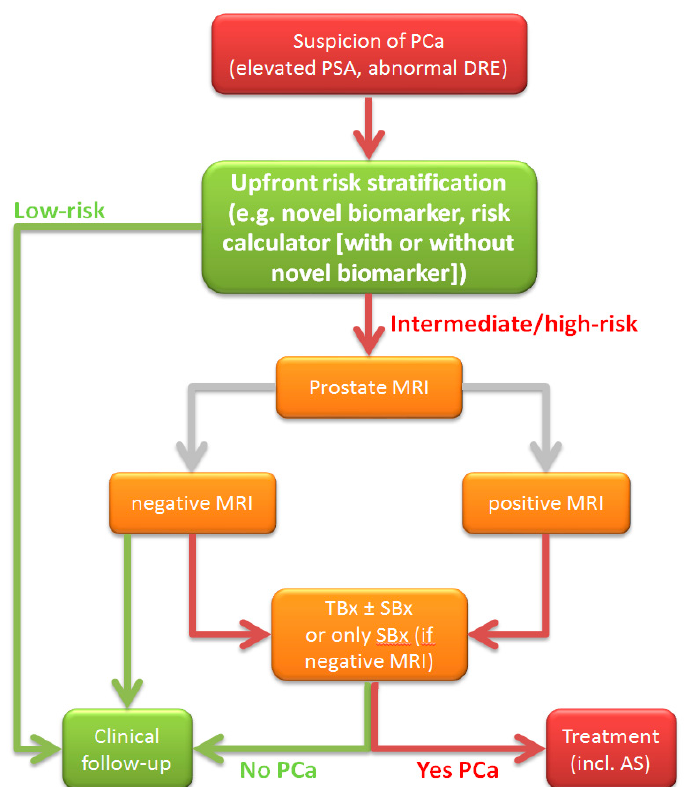
Figure 1. Flowchart of men with elevated prostate-specific antigen (PSA) and/or abnormal digital rectal examination (DRE), with the combination of upfront risk stratification and if indicated prostate MRI and biopsy. PSA: prostate-specific antigen; DRE: digital rectal examination; PCa: prostate cancer; MRI: magnetic resonance imaging; PI-RADS: MRI suspicion score; TBx: MRI-targeted biopsy; SBx: systematic biopsy; AS: active surveillance.